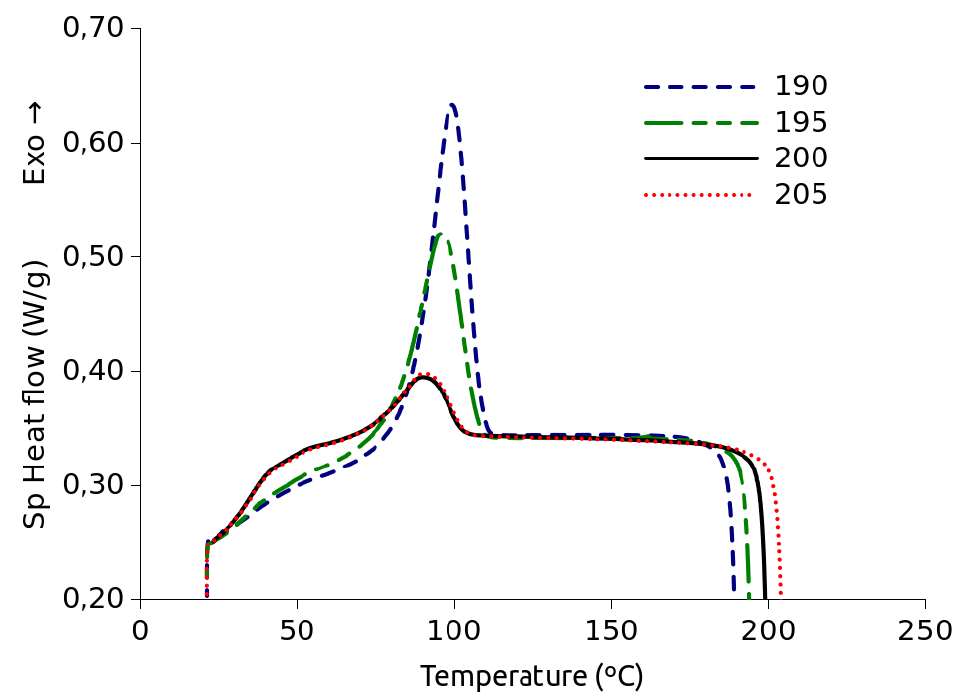
Figure 1. Plots of the DSC cooling scans from isothermal treatment at the indicated temperatures. Figure 2a shows the DSC isothermal plots obtained from the melt at the indicated temperatures. Figure 2b represents the heating scans just after the isothermal treatments represented in Figure 2a. The isothermal plots show two crystallization events,